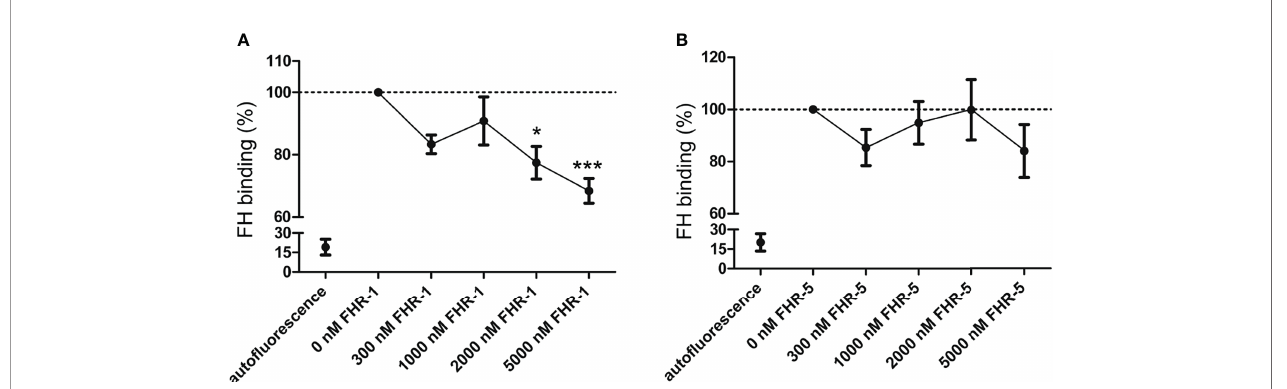
FIGURE 2 | Competition between FHR-1/FHR-5 and FH for binding to neutrophils. Neutrophils were preincubated with increasing concentrations of (A) unlabeled recombinant FHR-1 or (B) FHR-5, then fl uorescence-labelled FH (50 µg/ml; 300 nM) was added to the cells. Bound FH was detected by fl ow cytometry. Data represent means ± SEM from fi ve (A) and four (B) independent experiments. Differences with p < 0.05 were considered statistically signi fi cant and compared to the FH treated samples without competitor protein (one-way ANOVA with Dunnett ’ s multiple comparison test, * p < 0.05*** p < 0.001).